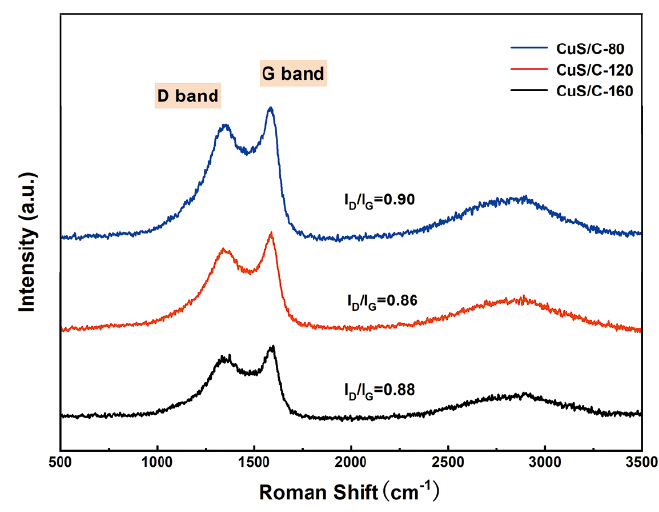
Figure 3. Raman spectra of CuS/C ‐ 80, CuS/C ‐ 120, and CuS/C ‐ 160 nanoparticles. The morphologies and microstructures of the CuS / C-80, CuS / C-120, and CuS / C-160 samples were characterized using scanning electron microscopy (SEM, Figure 4a–f). When the experimental ◦ temperature reaches 80 C, the granulation in the sample is manifest. When the temperature increases ◦ from 120 to 160 C, the nanoparticles are connected into a block. Further, when the temperature is ◦ 120 C, they collide with other nanoparticles to form a dense cloud-like nanostructure. Compared with CuS / C-160 and CuS / C-80, CuS / C-120 exhibits a more regular flocculent network structure, with almost no agglomeration and a smoother surface. The homogeneous nanoparticles in the sample contain gaps between them. These gaps are beneficial for the di ff usion and transfer of the electrolyte ions, which enhances the conductivity of the samples, endowing it with the best electrochemical properties among the samples. Therefore, temperature is the key factor that a ff ects the structure of the